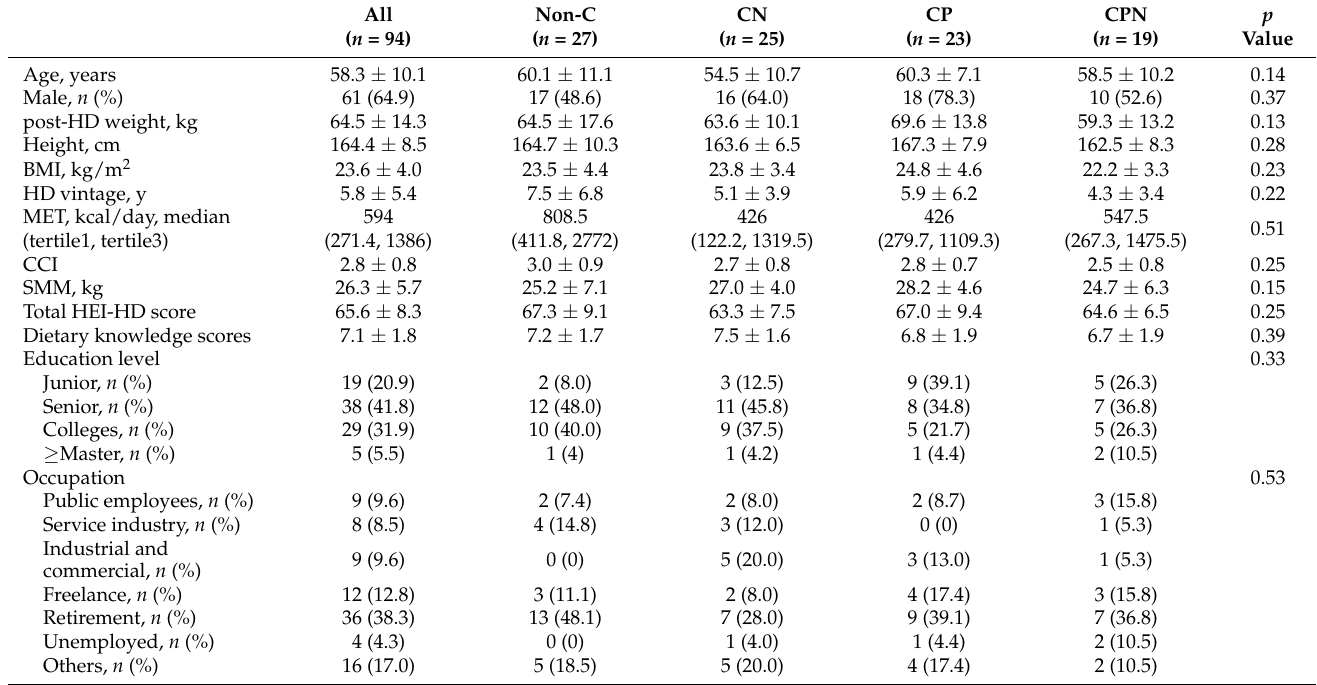
Figure 1. Study flow of HD patients. Non-C, no course for patients and nurses; CN, course for nurses; CP, course for patients; CPN, course for patients and nurses; PBF, percentage body fat. Table 2. Baseline characteristics of all participants.